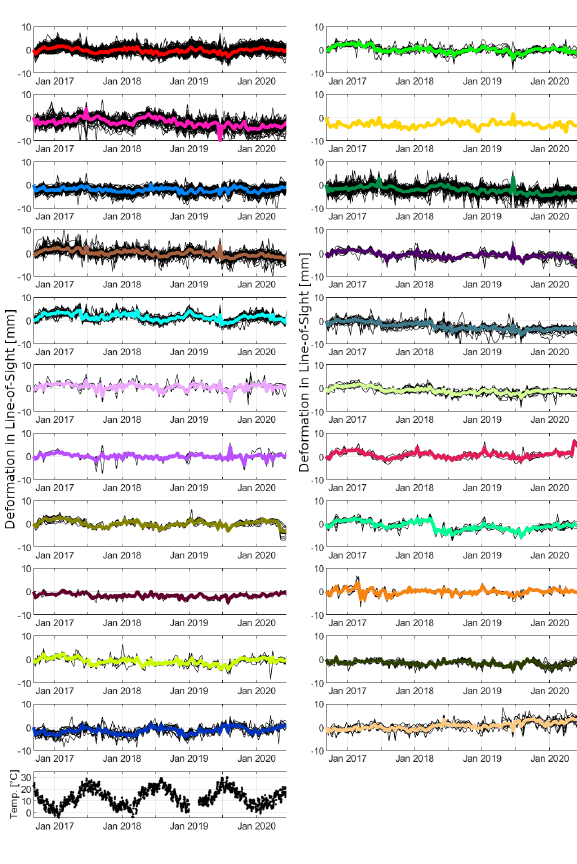
Figure 7. Time series for each cluster. The colors correspond to the ALS point cloud (Fig. 5) and the t-SNE plot (Fig. 6). The daily temperature is shown in the lower left plot these points. The temperature data was provided by Amt f¨ur Umweltschutz, Stadt Stuttgart